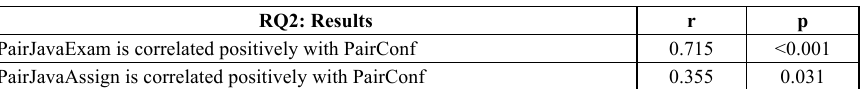
Table 5. Results summary of